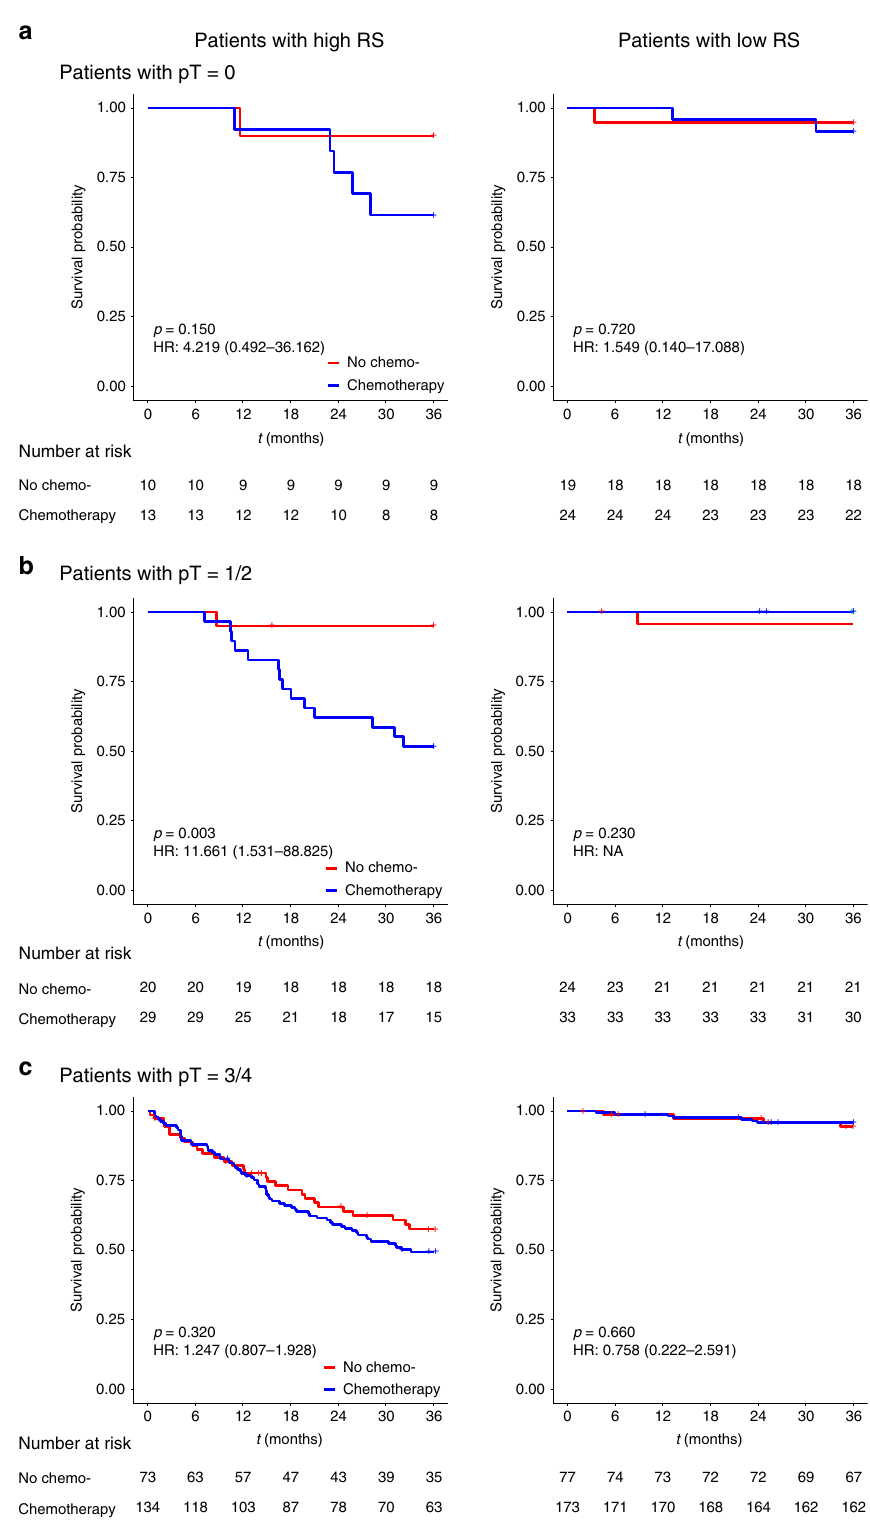
Fig. 5 Adjuvant chemotherapy bene fi ts based on DMFS according to pT stage and RS. a – c K – M DMFS curves are shown for patients according to their use of adjuvant chemotherapy. In addition, patients with a high RS (left) were strati fi ed according to pT0 ( n = 23, upper), pT1 – 2 ( n = 49, middle), and pT3 – 4 ( n = 207, bottom). Patients with a low RS (right) were also strati fi ed according to pT0 ( n = 43, upper), pT1 – 2 ( n = 57, middle), and pT3 – 4 ( n = 250, bottom). p values were calculated using two-sided log-rank test. RS radiomic signature; HR hazard ratio; DMFS distant metastasis-free survival; LARC locally advanced rectal cancer. Source data are provided as a Source Data fi